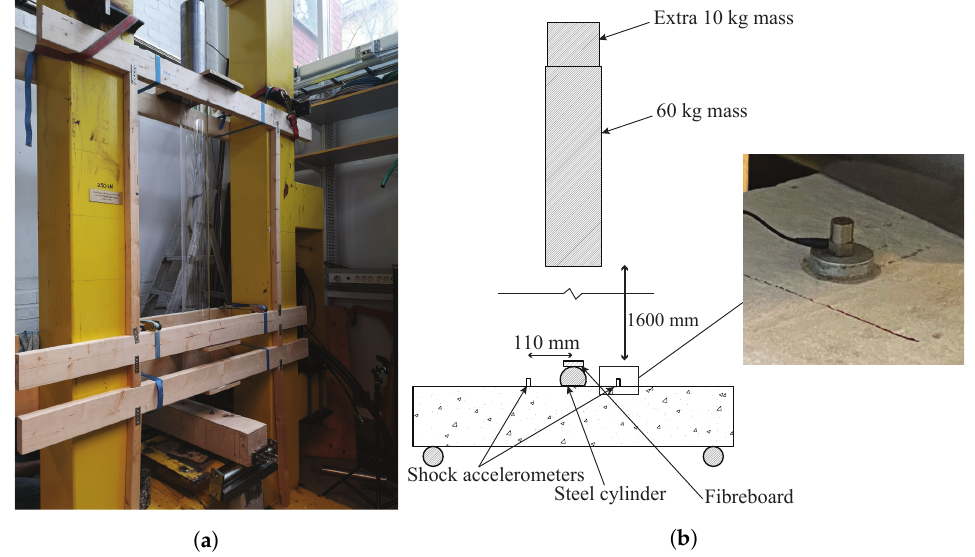
Figure 5. ( a ) Setup used for the impact tests and ( b ) schematic of the